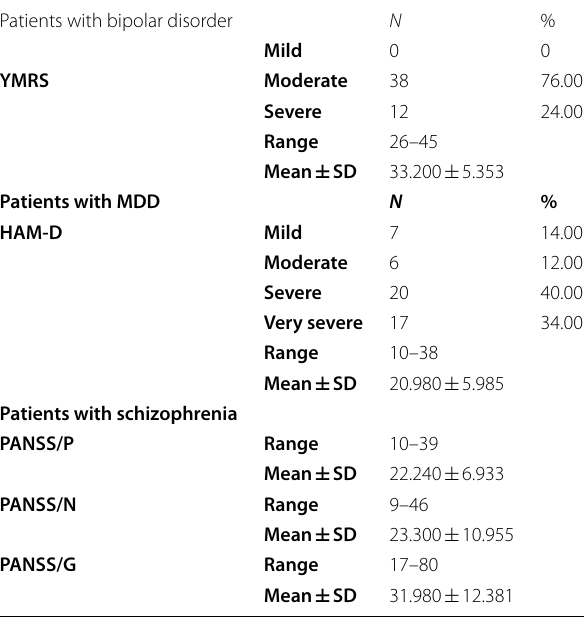
Table 2 Severity and symptom dimension of schizophrenia, bipolar, and MDD among patient group Patients with bipolar disorder